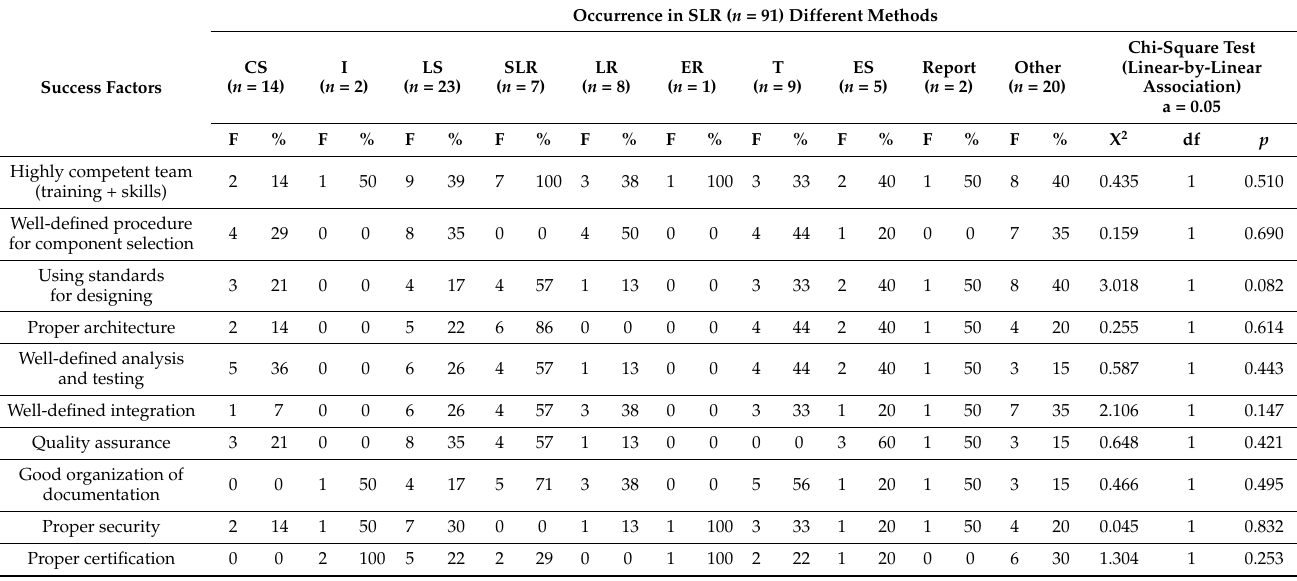
Table 4. Identified success factors list from SLR across different